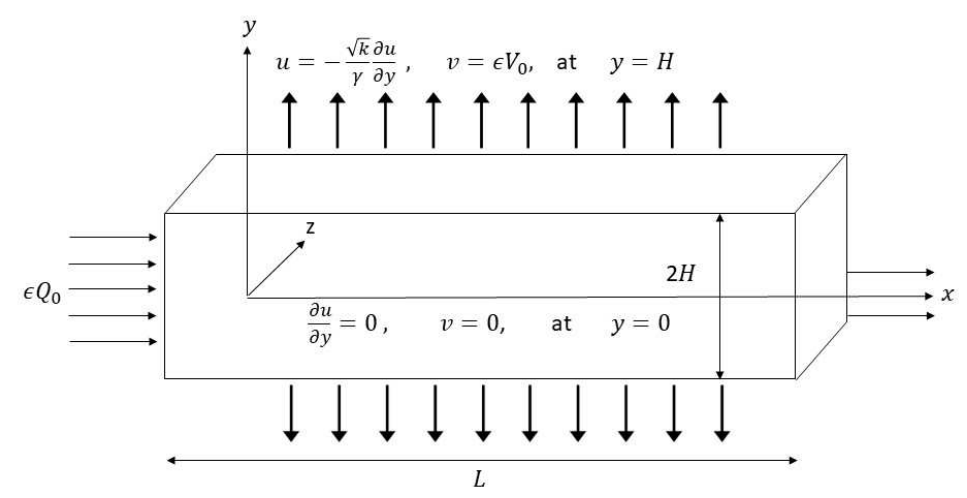
Figure 1. Geometry of the